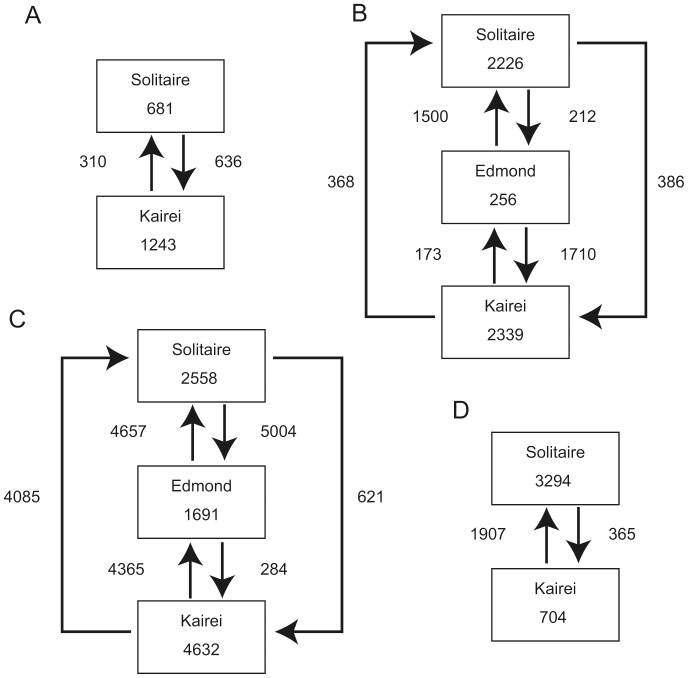
Schematic images of the results of MIGRATE analyses.A, A. rodriguezensis; B, R. kairei; C, Alviniconcha sp. type 3; and D, scaly-foot gastropod.